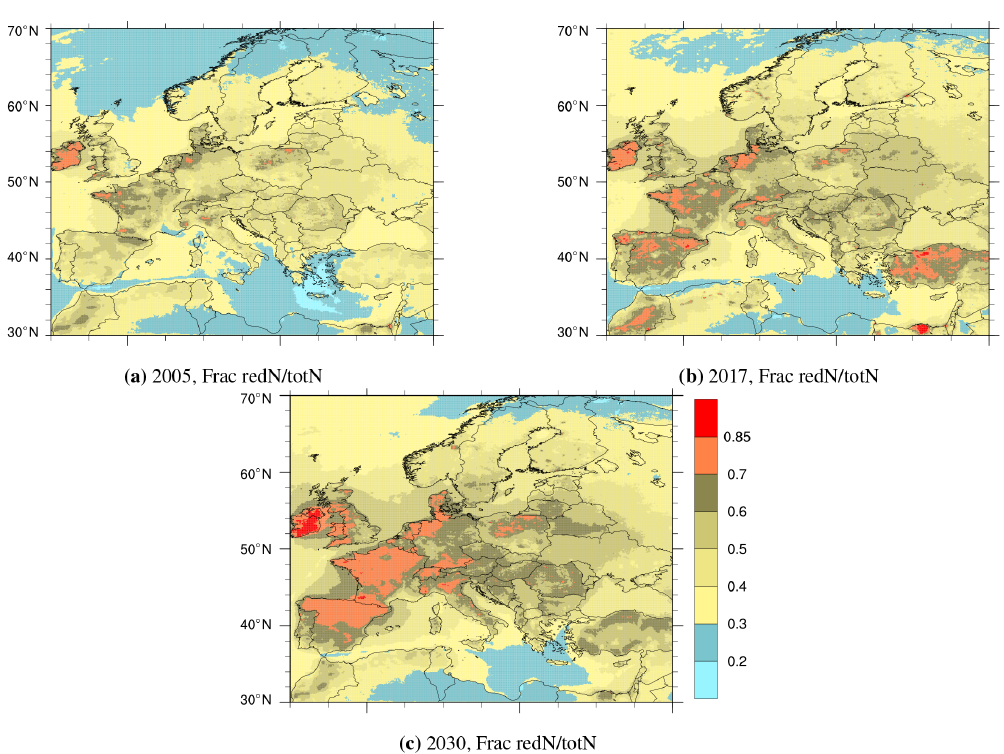
Figure 4. Fraction of reduced N deposition relative to total N (reduced plus oxidised nitrogen) deposition, calculated with year 2005, 2017, and 2030